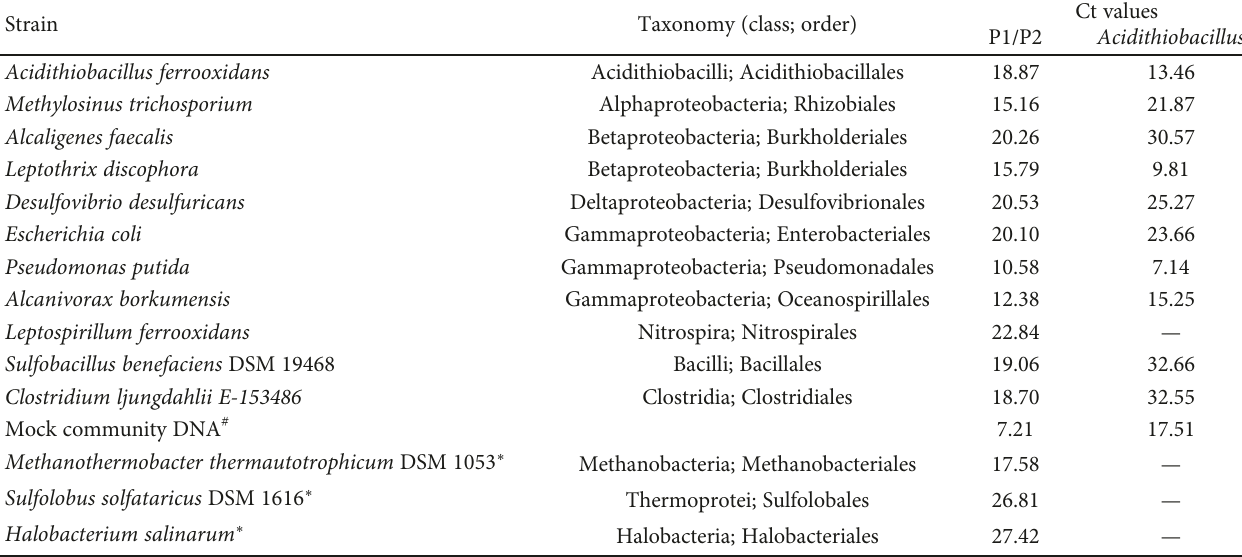
Table 1: The control strains used in the PCR tests for the genus-speci fi c primers. All primers were tested on the same DNA preparates, i.e., the amount of DNA used in the universal bacterial and Acidithiobacillus sp. 16S rRNA gene targeting reactions is the same. However, DNA concentration may vary between preparates of di ff erent